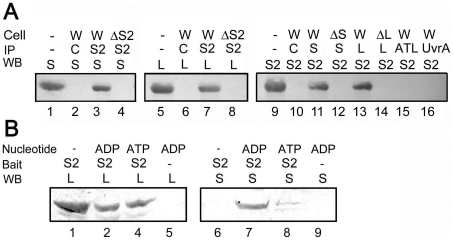
Interactions between MutS and MutS2, and MutL and MutS2.(A) Co-immunoprecipitation. “Cell” indicates strains used for immunoprecipitation, where W, ΔS, ΔL, and ΔS2 represent the wild-type, ΔmutS, ΔmutL, and ΔmutS2 strains, respectively. IP and WB indicate antibodies used for immunoprecipitation and Western blotting, respectively. S, L, S2, ATL, and UvrA indicate anti-MutS, -MutL, -MutS2, -ATL protein, and -UvrA antibodies, respectively. C indicates pre-immune antibody. (B) Pull-down assay. S2 indicates recombinant His6-tagged MutS2 used as a bait protein. WB indicates antibodies used for Western blotting. L and S indicate anti-MutL and -MutS antibodies used for Western blotting.